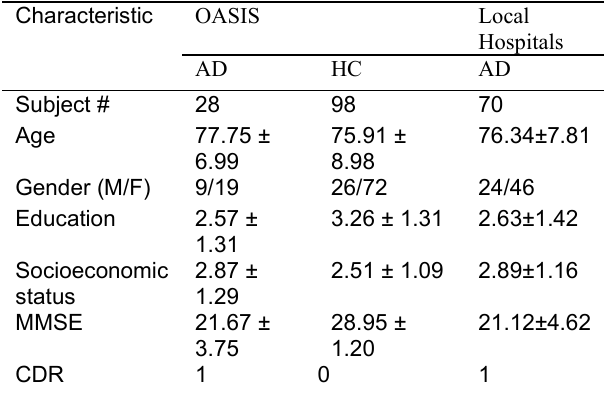
Table 3 Demographic status of